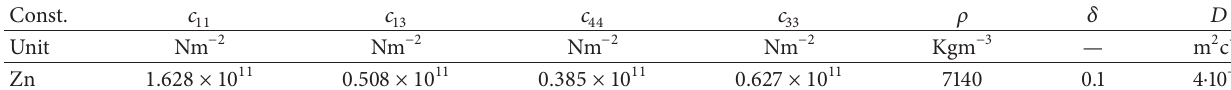
Table 1: Basic data for single crystal of zinc.